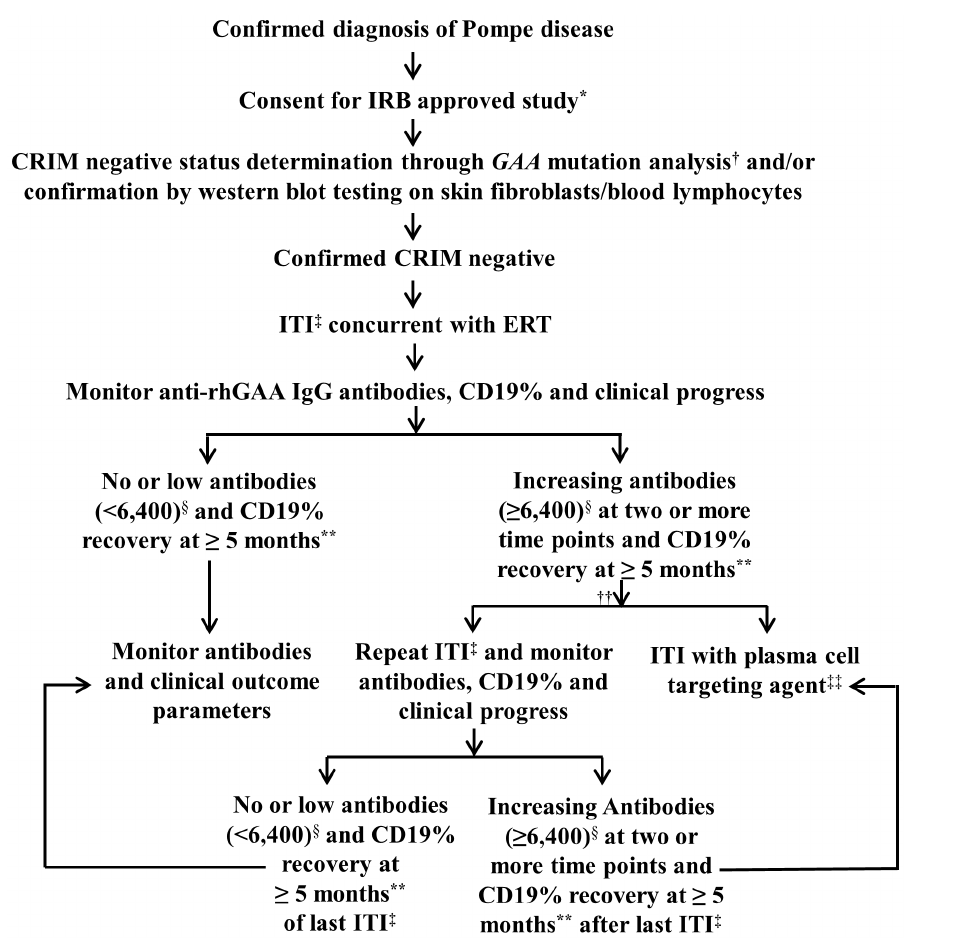
Figure 1. An algorithm for the management of cross-reactive immunologic material (CRIM)-negative (CN) infantile Pompe disease patients. * Institutional review board (IRB) approved study (NCT01665326; www.clinicaltrials.gov) for rapid determination of CRIM status and long- term follow-up of response to treatment and ITI in Pompe disease. { CN status determination from an established CRIM negative mutation database, which allows prediction of CN status in more than 90% cases [15]. ` ITI regimen is shown in Figure 2. 1 Based on the literature antibody titers sustained at $ 6,400 results in a suboptimal therapeutic response to ERT. For that reason, 6,400 was used a cutoff for further intervention [9,19]. **Based on the half-life of rituximab, CD19% recovery is typically noted around 5 months. {{ The decision to repeat the same ITI regimen (figure 3) or to administer ITI with a plasma-cell-targeting agent [20] should be based on multiple factors including, but not limited to, patients clinical status, CD19% and Fc c receptor polymorphism. `` ITI regimen with plasma cell targeting agent such as bortezomib has been described previously [20].